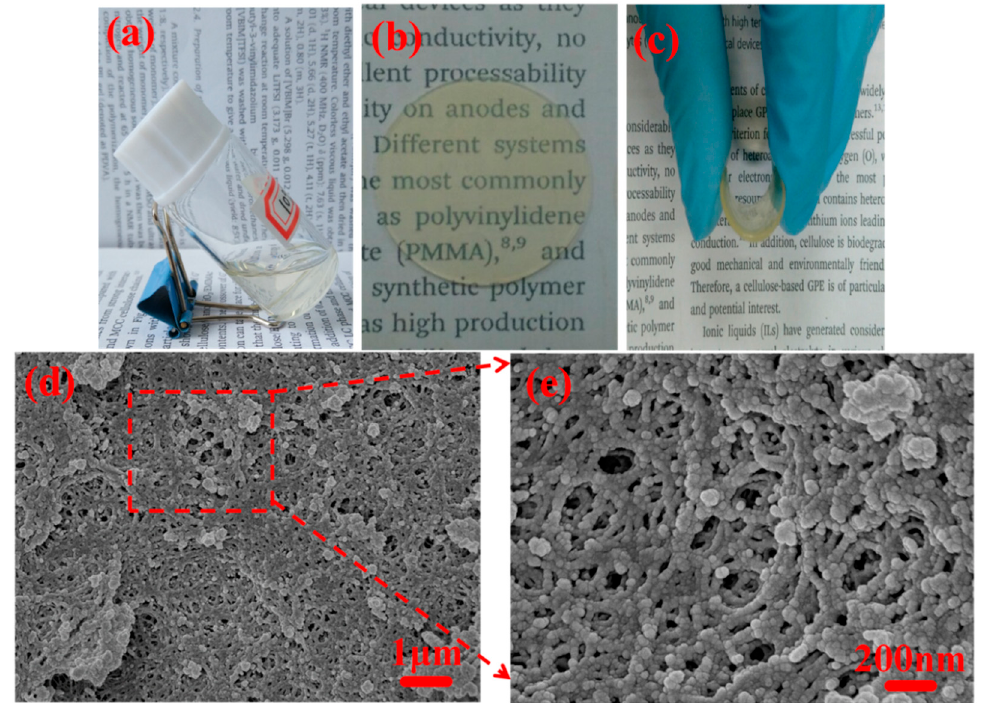
Figure 2. Photographs of ( a ) the ionic liquid solution, ( b ) round shape ionogel, and ( c ) bent round shape ionogel. ( d , e ) SEM images ofcross-sections of ionogels.